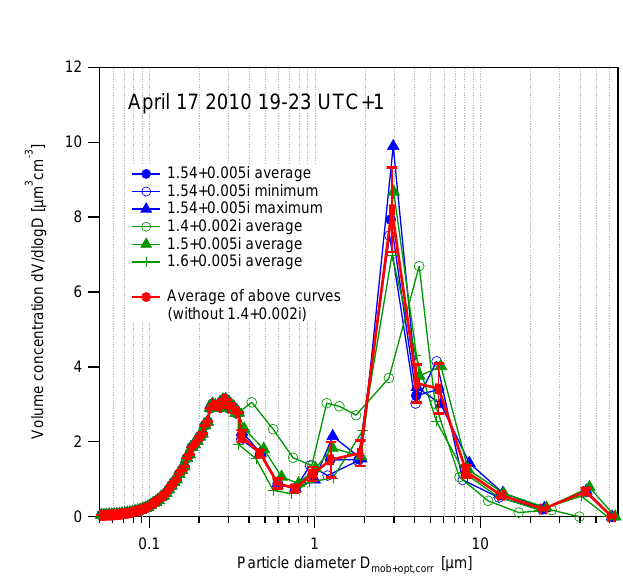
Fig. A4. Influence of the selected refractive index on the volume distribution measured at the Jungfraujoch during the first volcanic plume maximum in April. The shown average curve and standard deviation (red) does not include the unrealistic distribution obtained for